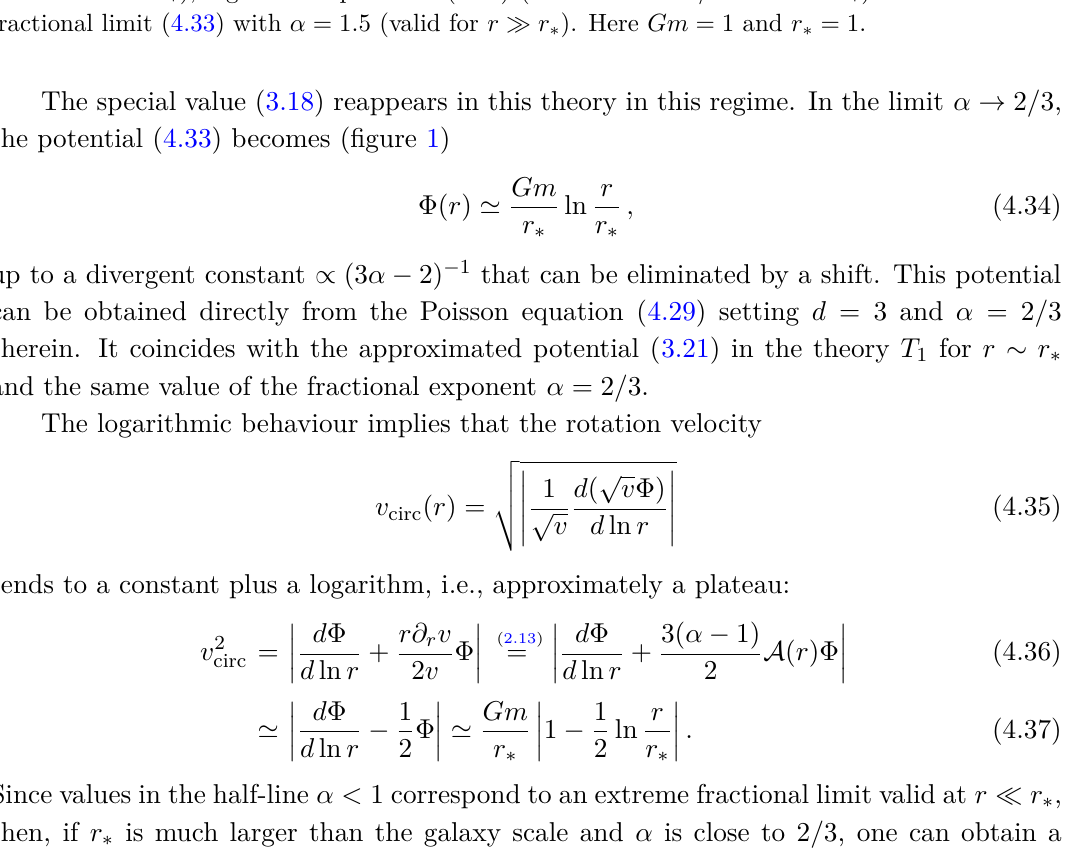
). Solid ∗ ) and the extreme ∗ ). Here Gm = 1 and r = 1 ∗ ∗